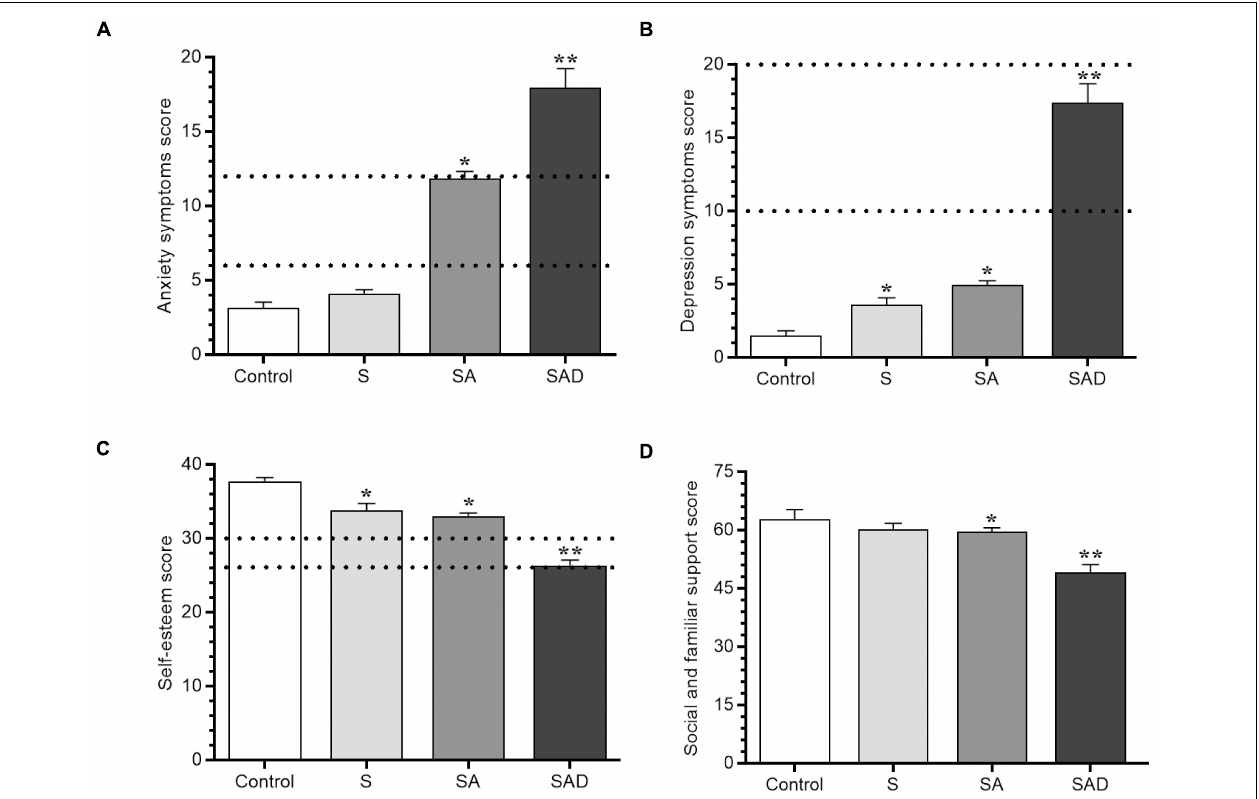
FIGURE 2 | Socio-affective scores for (A) anxiety, (B) depression, (C) self-esteem, and (D) social and familiar support. The following groups were compared: S, stress; SA, stress and anxiety symptoms; SAD, stress, anxiety, and depression symptoms. Dashed lines show the interval of a mild level of anxiety and depression symptoms and the average self-esteem score. * p < 0.05 vs. S and control groups; ** p < 0.001 vs. SA, S, and control groups (Dunn test). The results are expressed as mean ± SEM.